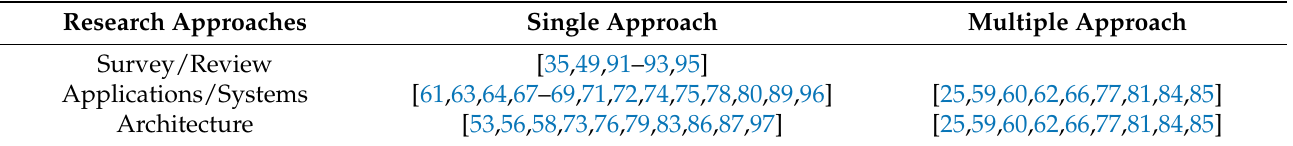
Table 5. Research